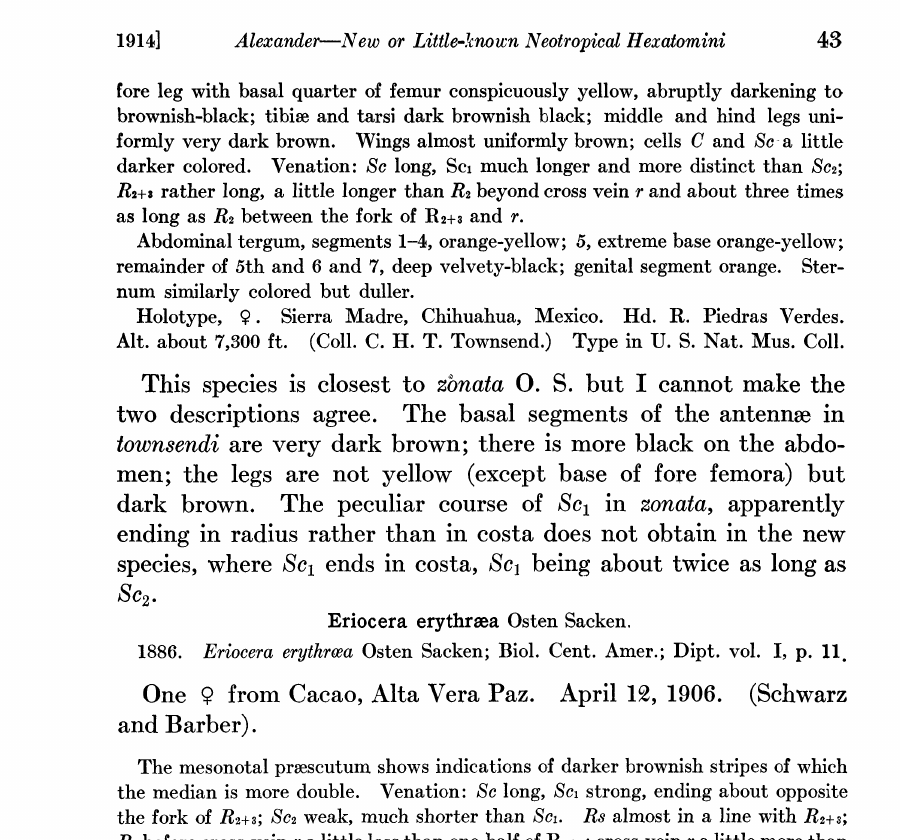
the fork of R+3; Sc. weak, much shorter than Scl. Rs almost in a line with